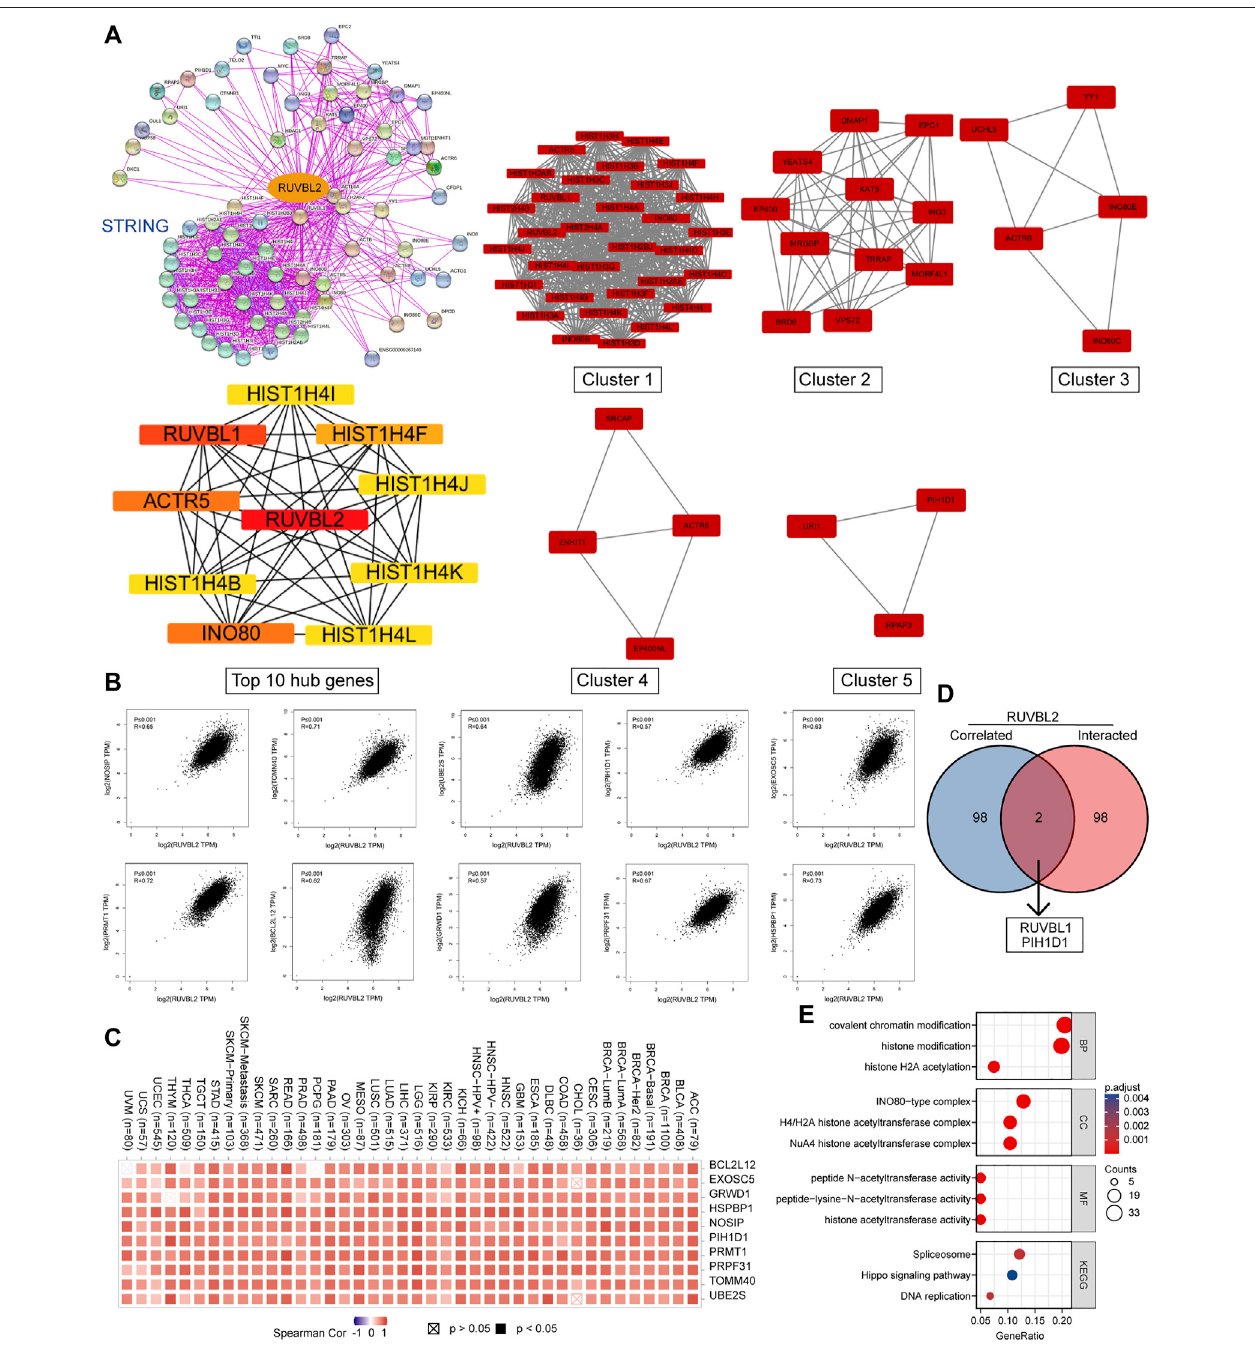
FIGURE 7 | The results of gene enrichment analysis. (A) 100 Reptin-binding proteins were shown via the STRING tool. Five sub-network modules (Clusters 1 – 5) and the top 10 hub genes were presented using the Cytoscape plug-in, MCODE, and cytoHubba. (B) The association between Reptin and the selected top 10 Reptin- interacting genes. (C) The relevant heatmap data in cancer. (D) The overlap analysis of Reptin-binding and interacting genes. (E) The results of KEGG and GO analysis were